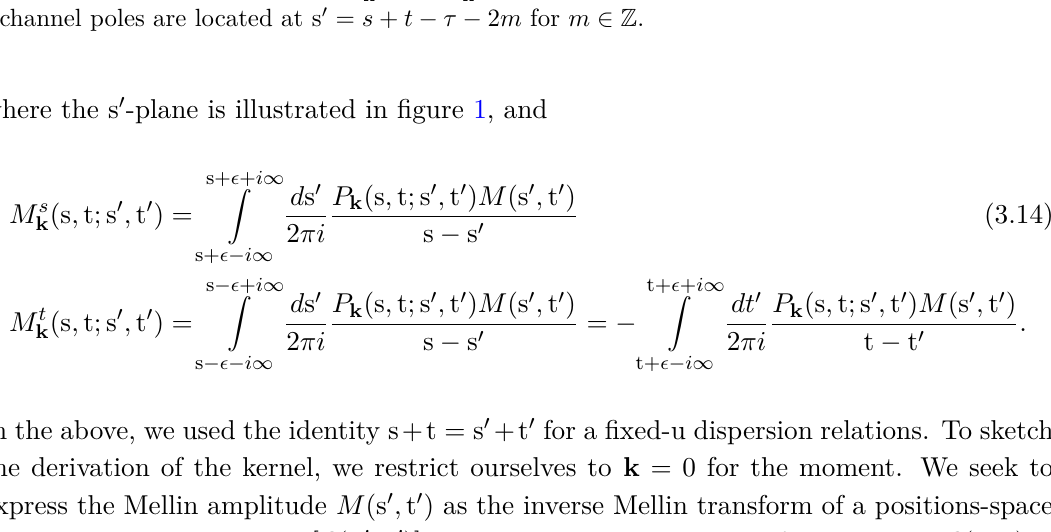
and M t . s -channel poles are located at s 0 = τ + 2 m while k k